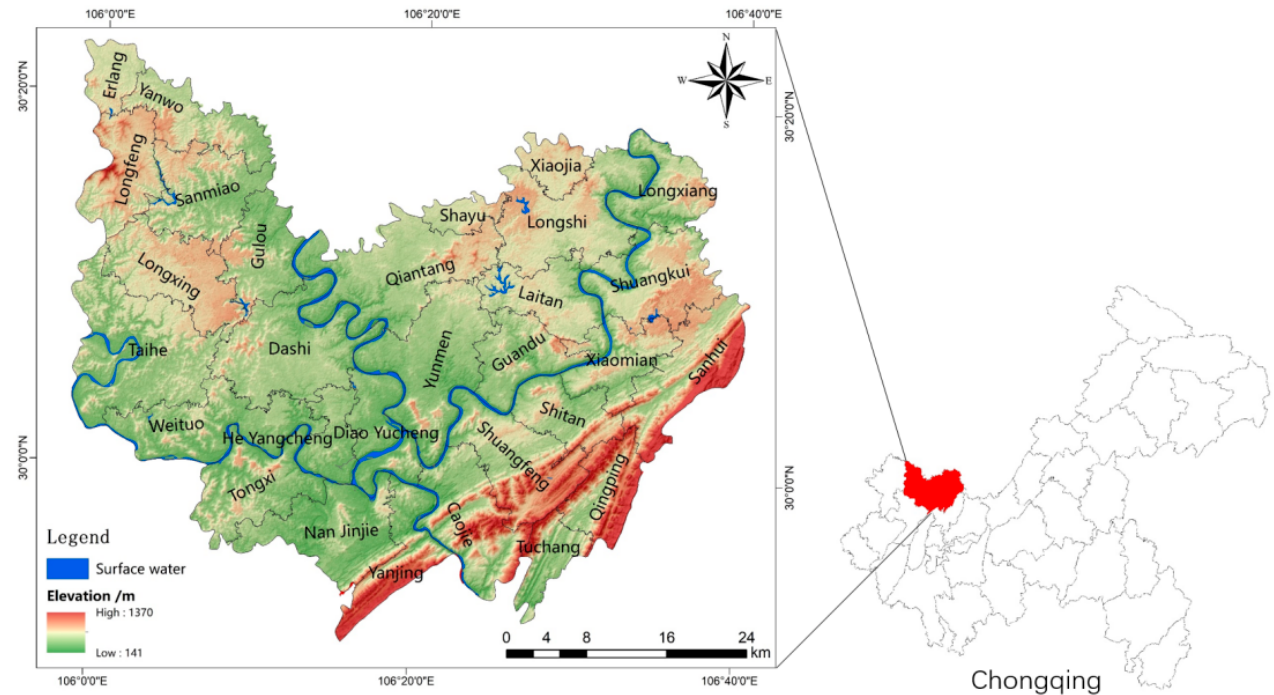
Figure 1. Topographic map of Hechuan District.